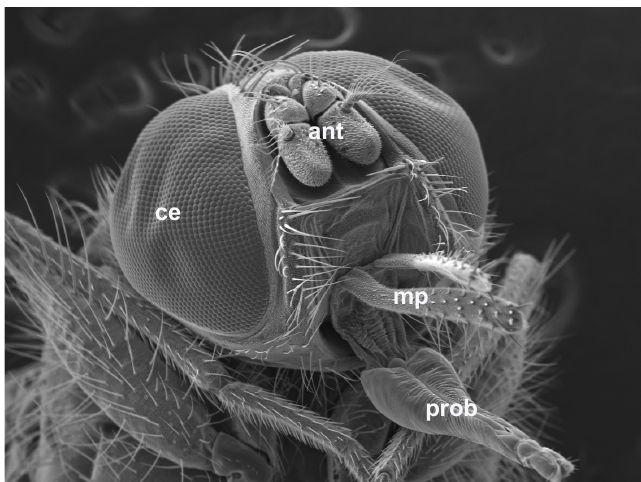
Figure 1. Scanning electron micrograph of a male horn fly head. Antennae (ant), maxillary palps (mp), and the proboscis (prob) were dissected as part of this study. Antennae are located between the compound eyes (ce), while the maxillary palps are located at the base of the proboscis.